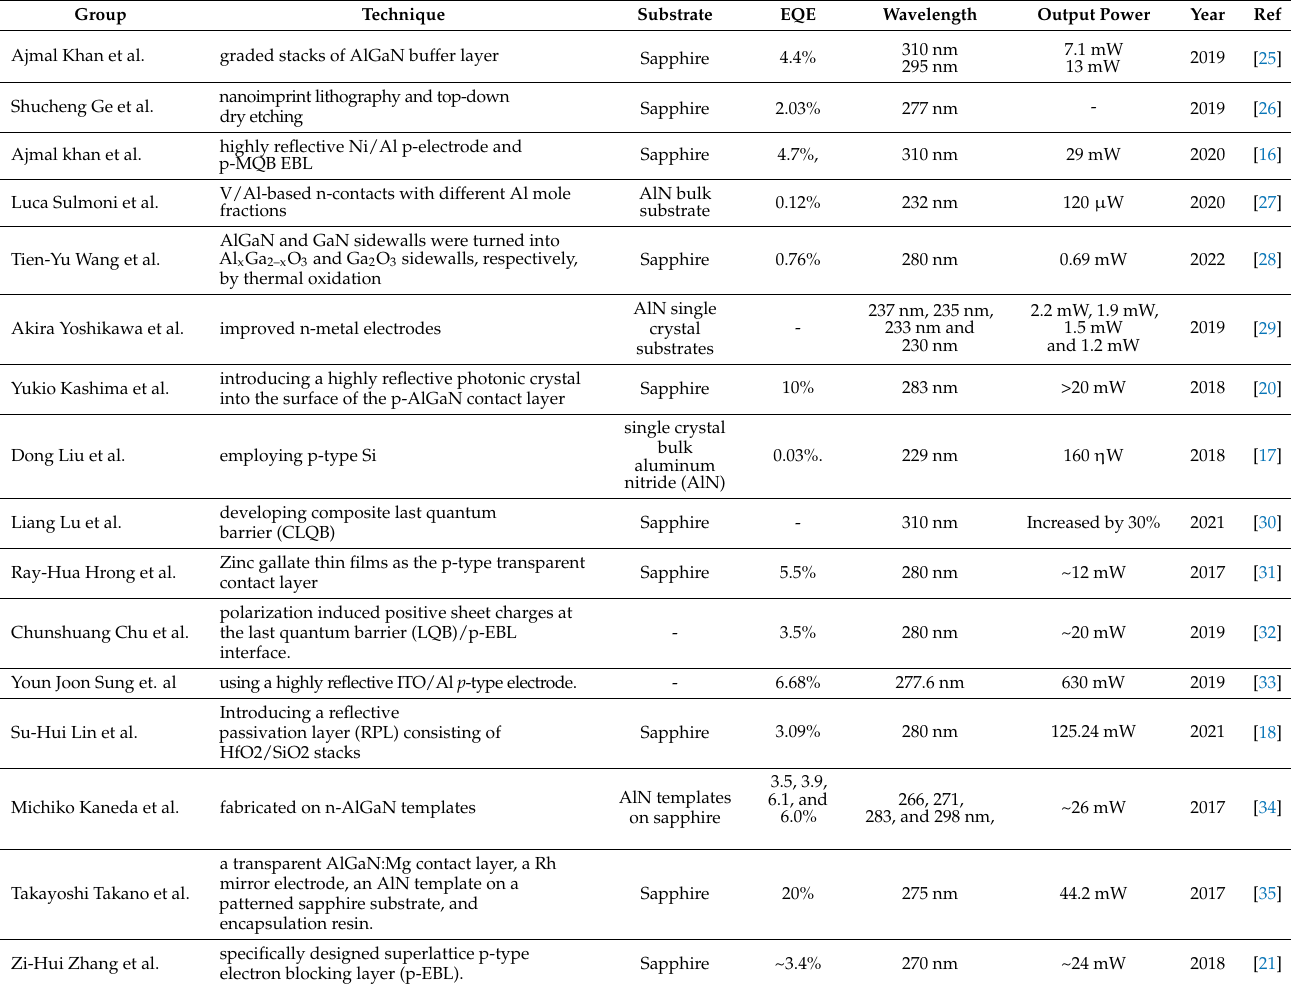
Table 1. A comparison of AlGaN-based UV-LED manufacturing